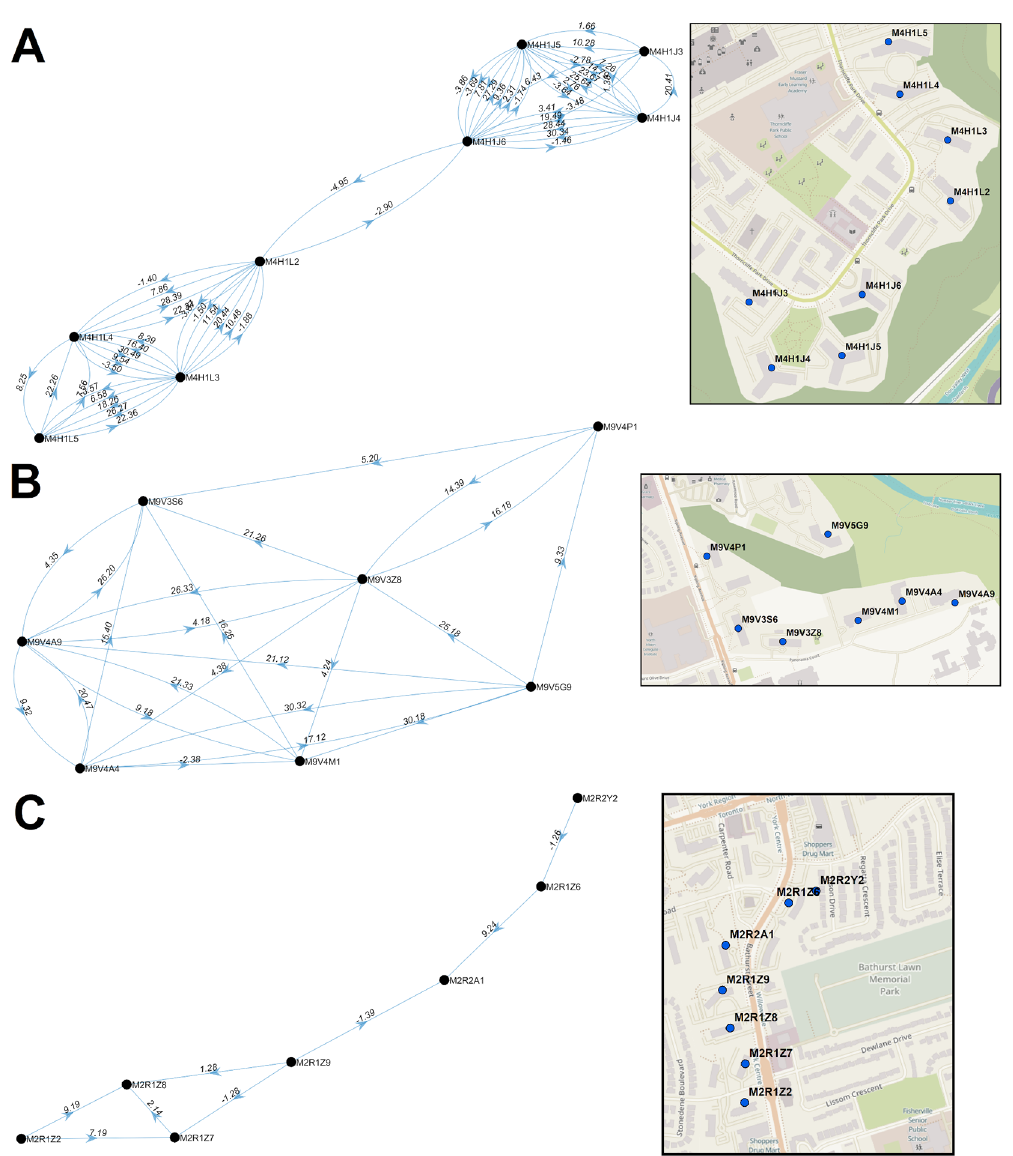
Figure 8. Multi-node directional networks of closely situated clustered postal codes. Directional acyclic graphs (left) organize adjacent high-case clustered PC streaks within the same FSAs ordered according to their occurrence. Panels indicate PCs within (A) M4H and (B) M9V in Toronto during wave 2. Each connection (or ‘ edge ’ ) linking two PCs represents a pair of clustered streaks occurring within 30 days of each other (all significant PC pairs are indicated in Extended data, 29 Section 1 - Table S7). Labels on each edge indicate the duration (in days) separating adjacent PC pairs and the number of cases which occurred in the combined streaks ( “ dates.cases ” ). Negative values, when present,indicatethenumber ofoverlapping daysof concurrent streaksinpairs ofPCs.Arrowsindicatethe temporal order of these paired streaks (from earlier to the later streak). Maps (right) show the physical locations of each PC within the corresponding